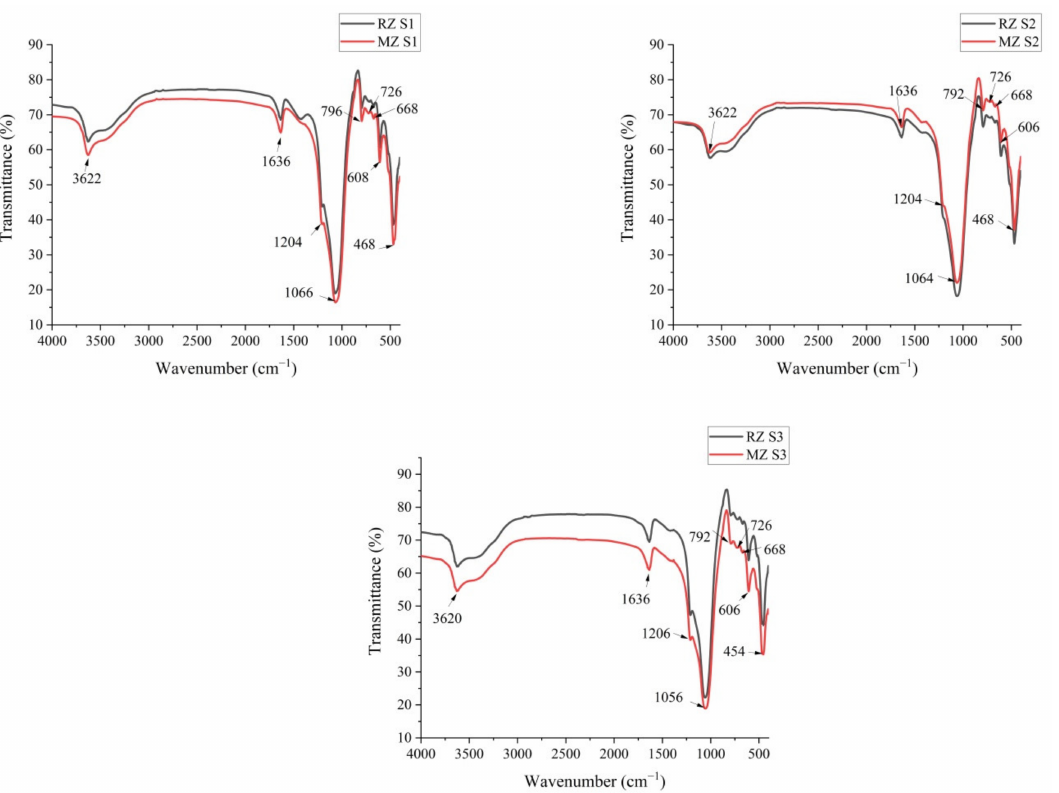
Figure 2. FT-IR spectra of RZ and MZ